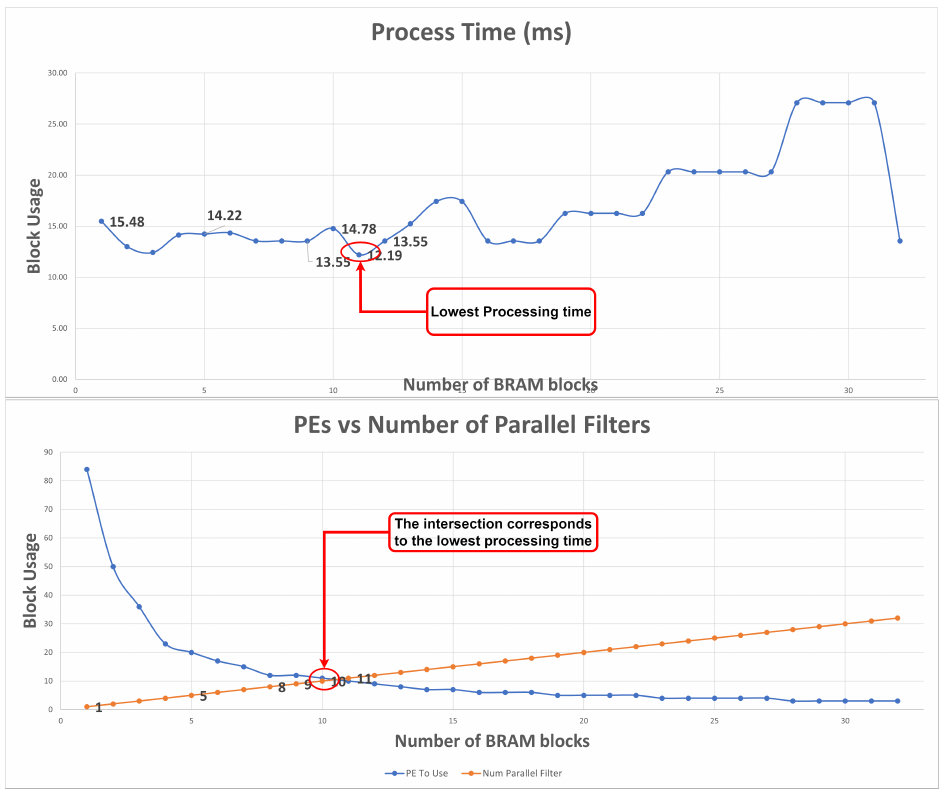
Figure 10. Number of PEs to use, number of parallel filters and processing time due to BRAM